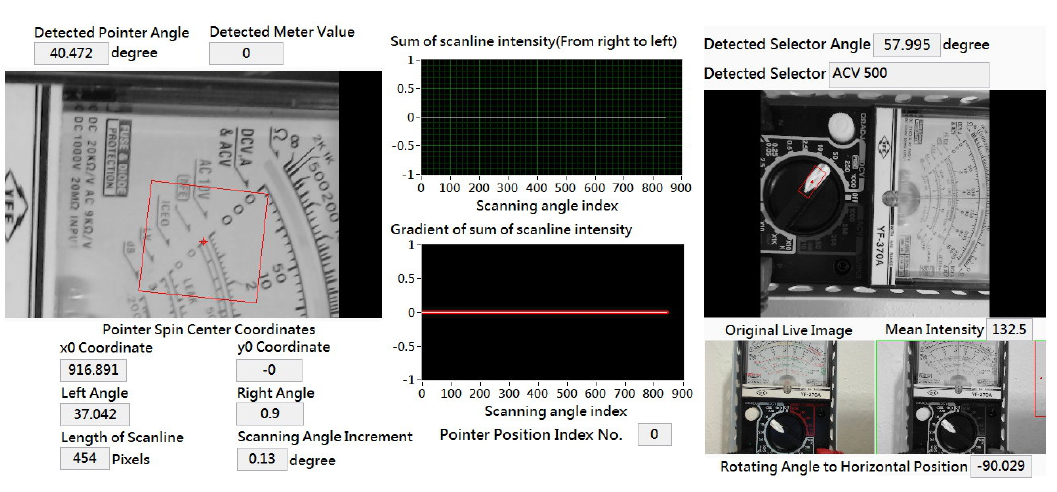
Figure 21. Reading the A-meter fails for the camera placed at H as indicated in Figure 20.